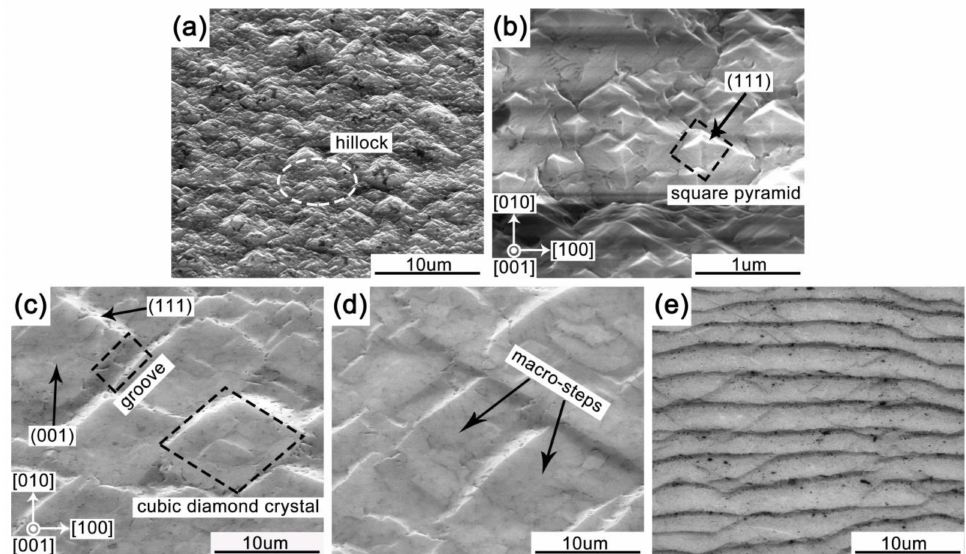
Figure 1. ( a ) SEM image of surface morphology of hillock interlayer; ( b ) magnified SEM image from the area marked with ellipse in ( a ); ( c – e ) SEM images of diamond surface after step-flow growth for 10 min, 20 min, and 40 h,